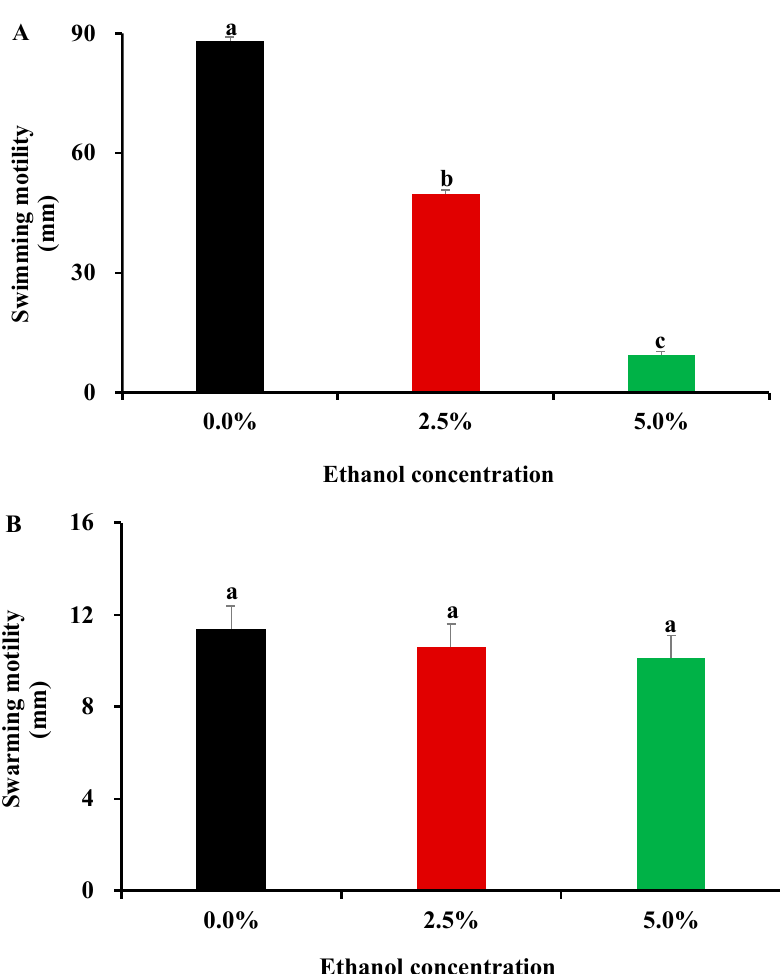
Figure 3. Influence of subinhibitory concentrations of ethanol (1/4 MIC, 2.5%; 1/2 MIC, 5.0%) on cell motility of S . Enteritidis. ( A ) Swimming motility; ( B ) Swarming motility. Different letters above vertical bars represent a significant difference ( p < 0.05).